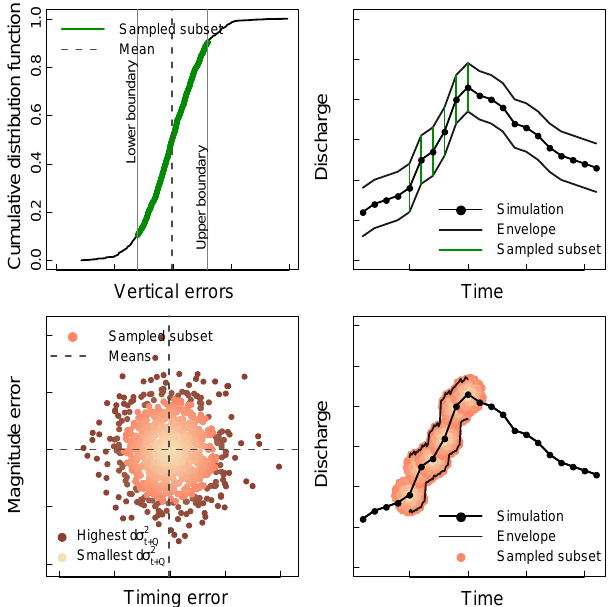
Figure 4. Sketch of the one- and two-dimensional error dressing method using normally distributed random numbers ( n = 1000). The upper row panels show the one-dimensional case with an em- pirical cumulative distribution function of errors (upper left panel) and an 80% subset thereof sampled according to increasing vari- ance contribution. The application (dressing) of the subset of errors to a hydrograph and the construction of the corresponding envelop curves is illustrated in the upper right panel. The lower row pan- els show the same procedure for the two-dimensional case. From the two-dimensional distribution of empirical errors (bottom left panel) 80% (colour-coded) are again sampled according to the com- bined variance contribution of both distributions (colour ramp). The bottom right panel contains a sketch of the two-dimensional error dressing method and the construction of envelope curves. Please note that the use of normally distributed numbers yields symmetri- cal samples and envelopes, which is usually not the case for real- world data, which are usually